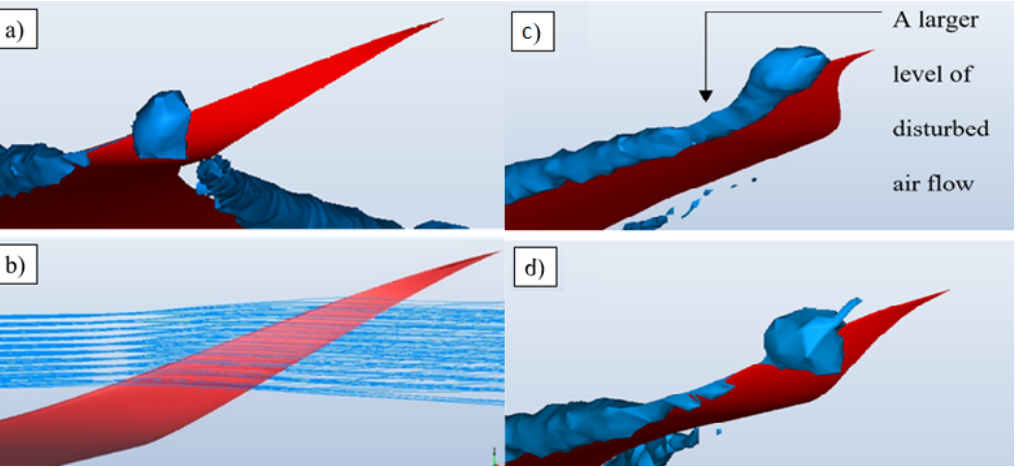
Figure 11. The flow streamline, showing ( a ) underside of aerofoil with attached winglet, ( b ) flow phenomenon over winglet, ( c ) disturbed air flow on winglet 1, and ( d ) disturbed airflow on winglet 2.